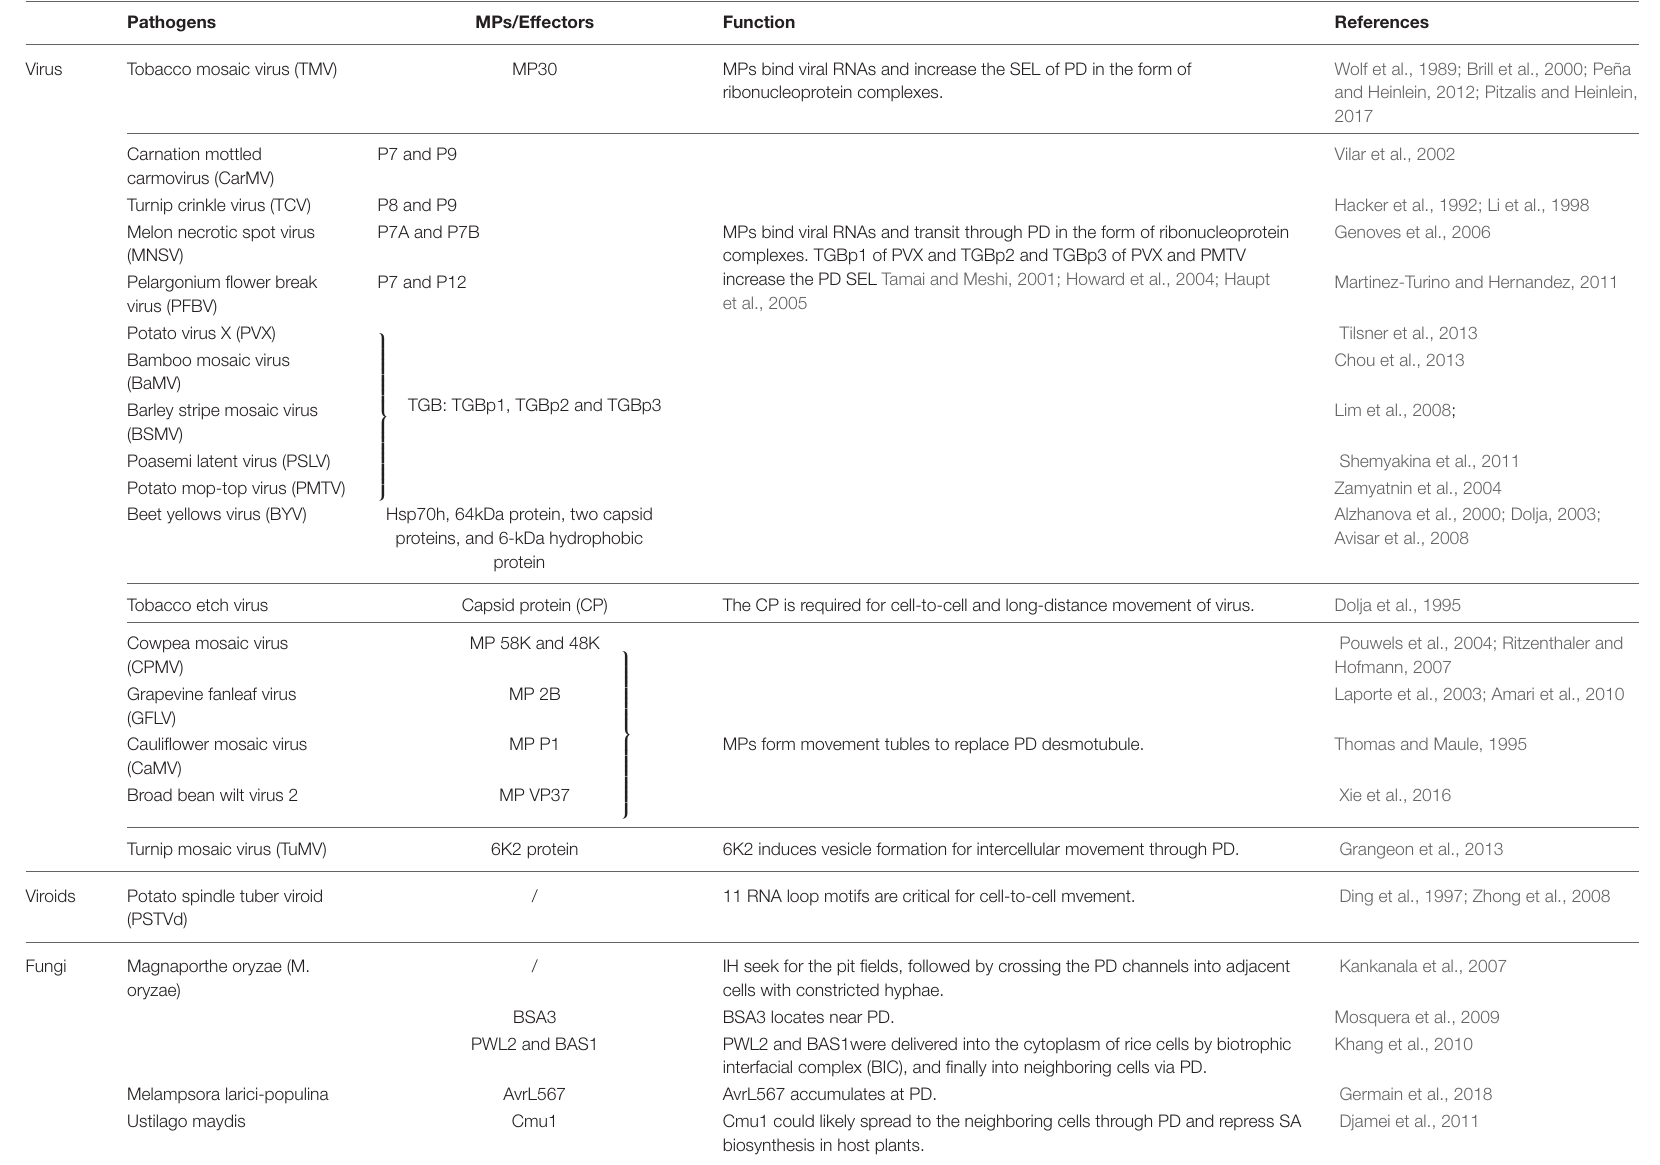
TABLE 1 | Viral, fungal, and bacterial pathogens and the effectors that move cell-to-cell through the plasmodesmata of attacked plants.